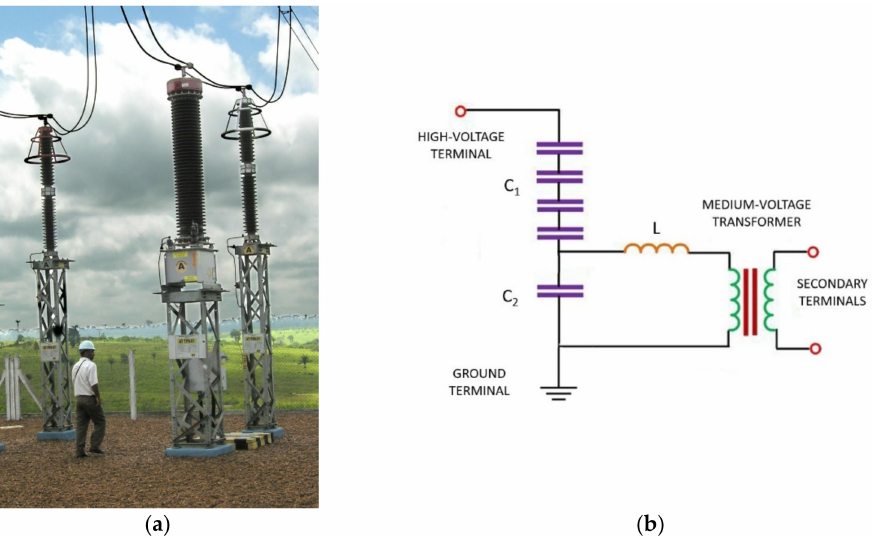
Figure 18. ( a ) A conventional capacitive voltage transformer (CVT) for 230 kV installed on the Altamira Substation in the state of Par á , Brazil. ( b ) Internal circuit diagram showing the capacitive